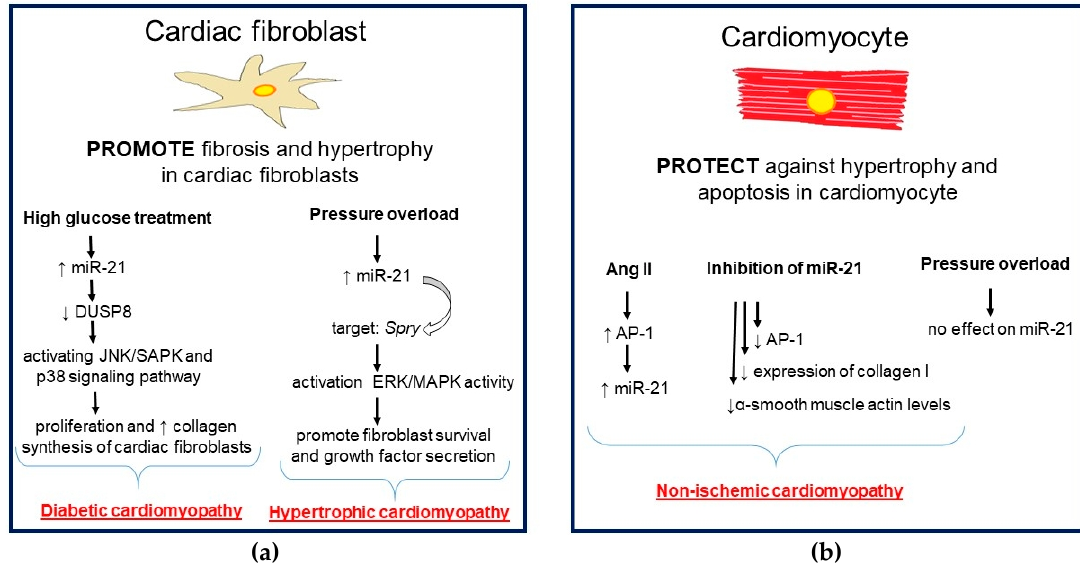
Figure 3. Cell-specific microRNA-21 (miR-21) expression in cardiomyopathies. In fibroblasts ( a ), miR-21 can promote cardiac fibrosis and cardiac hypertrophy. In cardiomyocytes ( b ), miR-21 can protect against hypertrophy and apoptosis. In fibroblasts of the pressure-overloaded heart ( a ), miR-21 is up-regulated, but not in cardiomyocytes ( b ). MiR-21 is involved in heart remodeling in non-ischemic and diabetic cardiomyopathy by promoting cardiac fibrosis. Figure assembled according to [95,97,100,122].